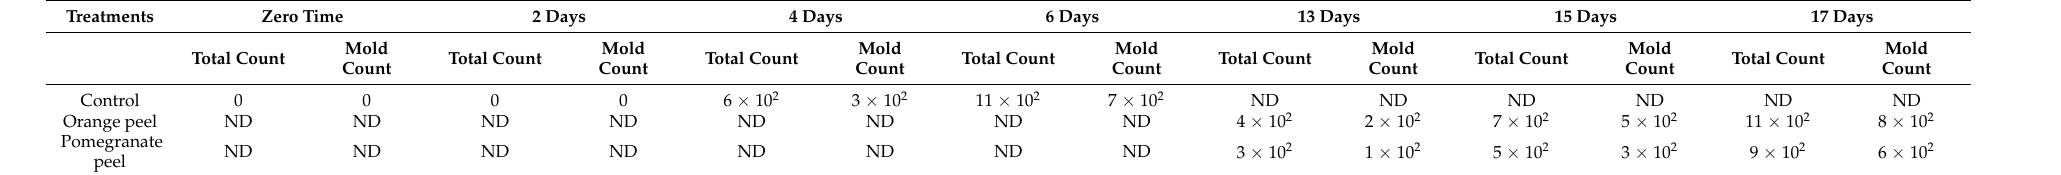
Table 15. Antimicrobial effect of orange and pomegranate peel on storage cake samples at room temperature